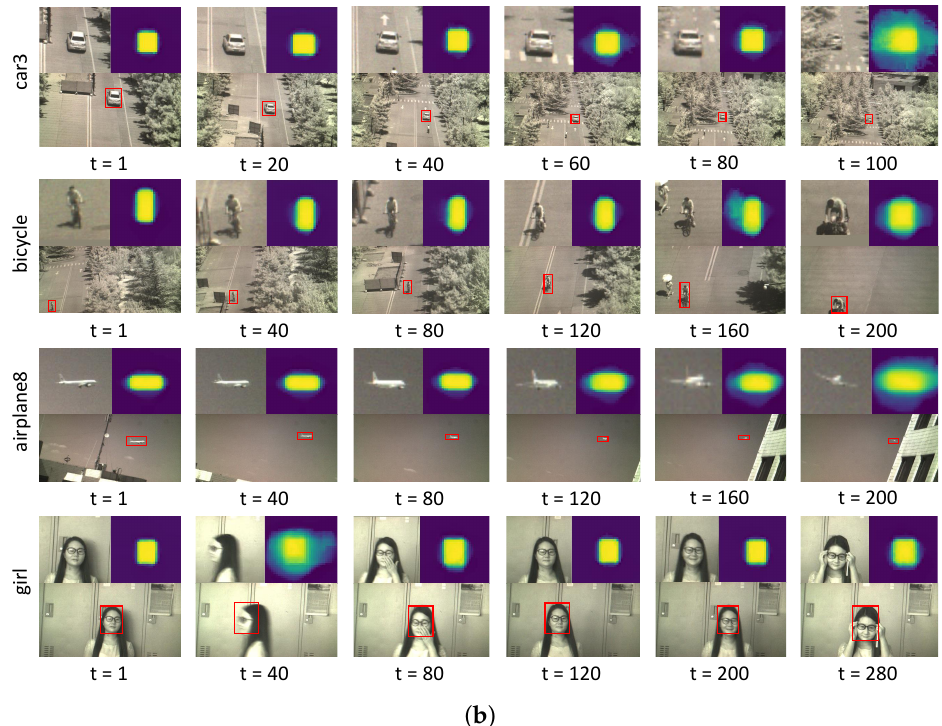
Figure 3. The strong attention response map for two datasets. It displays the attention map of objects in challenging scenarios. Each image consists of an initial image, cropped image, and the corresponding attention map. ( a ) The attention map of four sequences on IMEC16; ( b ) the attention map of four sequences on